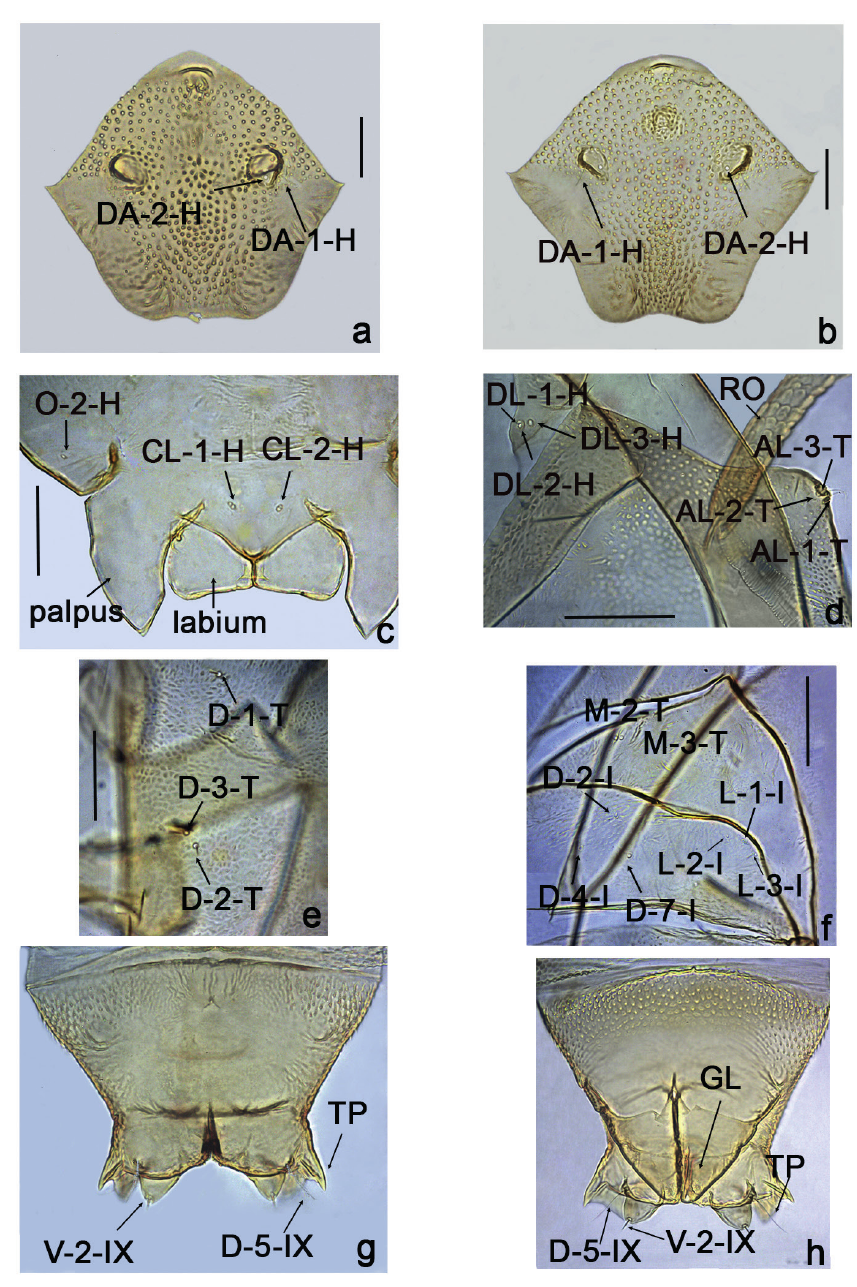
Figure 4 - Dasyhelea flavifrons Guérin-Méneville, a, c-g ) female pupa; b, h ) male pupa. a-b ) dorsal apotome; c ) mouthparts and clypeal/ labral and ocular sensillum (ventral view); d ) cephalothoracis sensilla; e ) dorsal sensilla; f ) metathorax and tergite 1; g-h ) segment 9. Anterolateral sensilla (Al- 1-T, AL-2-T, AL-3-T); clypeal/labral sensilla (CL-1-H, CL-2-H); dorsal apotome sensilla (DA-1-H, DA-2-H); dorsolateral cephalic sclerite sensilla (DL-1-H, DL-2-H, DL-3-H); dorsal setae (D-1-T, D-2-T, D-3-T); dorsal sensilla of segment 9 (D-5-IX); genital lobe (GL); methatoracic sensilla (M-2-T, M-3-T); ocular sensillum (0-2-H); ); respiratory organ (RO); tergite 1 sensilla (D-2-I, D-4-I, D-7-I, l-1-I, l-2-I, l-3-I); terminal processes (TP); ventral sensilla of segment 9